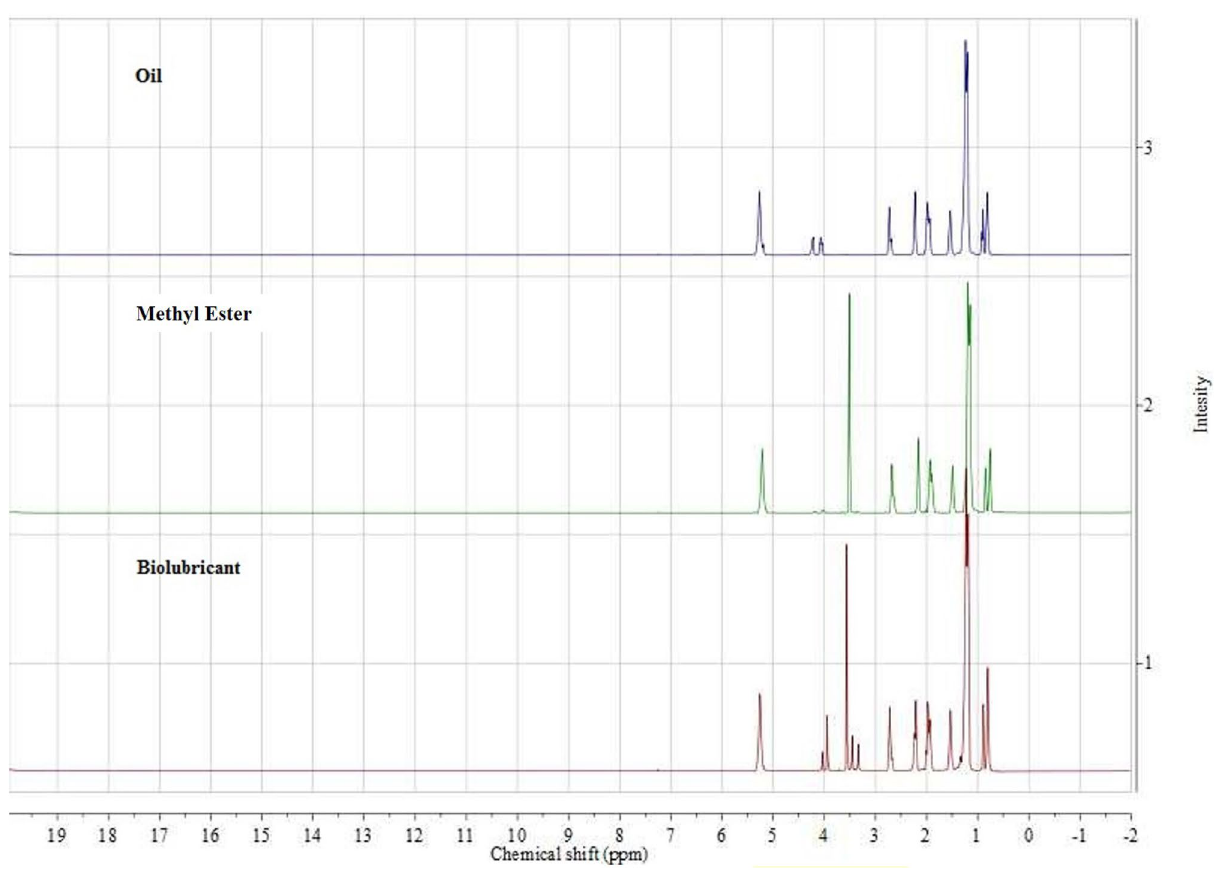
Figure 4. H-NMR spectrum curves for camelina oil, methyl ester and bio-lubricant.